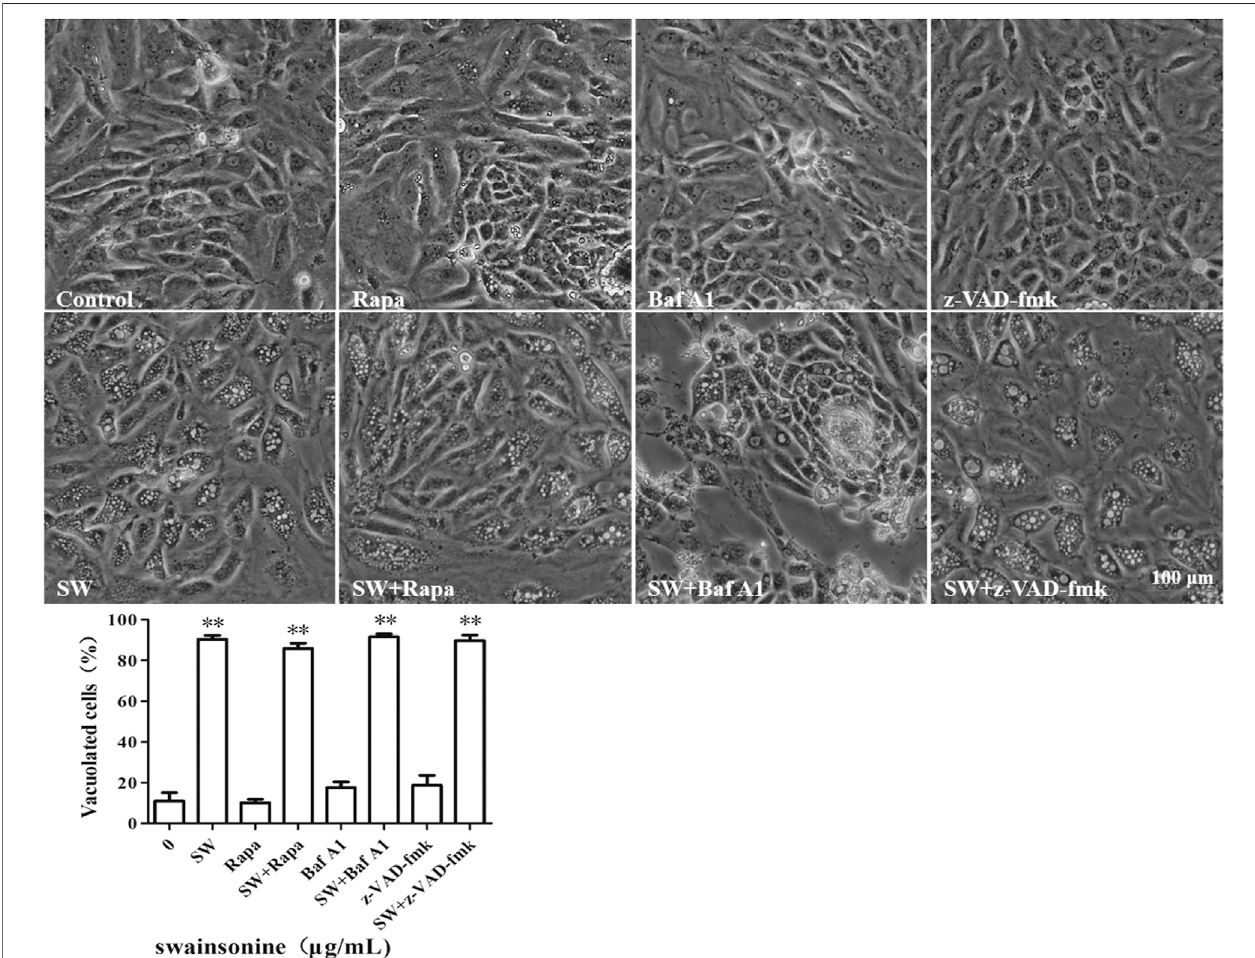
FIGURE 3 | SW induced cytoplasmic vacuolization which is independent of autophagy and apopotosis. Inverted microscopic images of RTECs treated with SW (400 μ g/ml)inthepresenceofautophagicactivatorslikeRapa,autophagicinhibitorslikeBafA1,andapoptosisinhibitorslikez-VAD-fmkfor24 h.Morphometricanalysis of vacuoles was performed with three different areas and the percentage of SW-induced vacuolated cells was calculated.